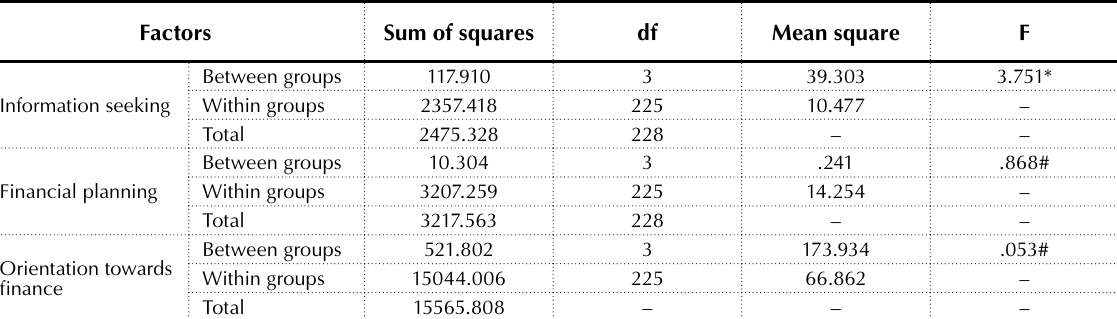
Table 5. ANOVA based on